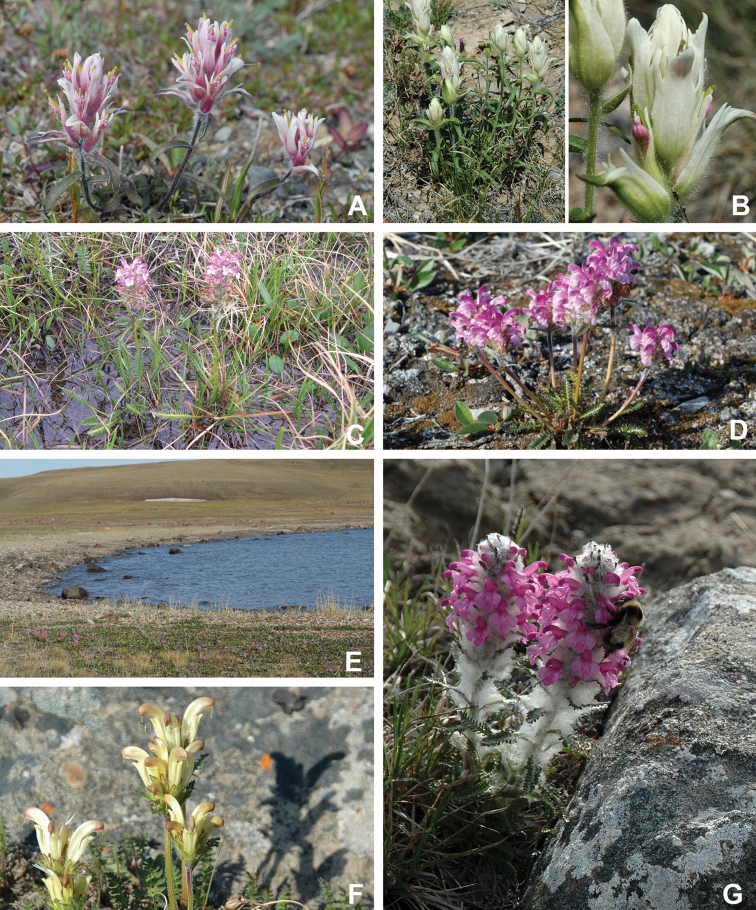
ACastilleja
elegans habit, Gillespie et al. 9822BCastilleja
elegans habit (left) and inflorescence (right), Gillespie et al. 9606CPedicularis
albolabiata habit, Gillespie et al. 7792DPedicularis
arctoeuropaea habit, Gillespie et al. 9628EPedicularis
arctoeuropaea habitat, Gillespie et al. 9628FPedicularis
capitata habit, Gillespie et al. 9992GPedicularis
lanata habit, Kuujjua River, NT, 15 July 2010. Photos A, C–E by L.J. Gillespie and B, F, G by R.D. Bull.